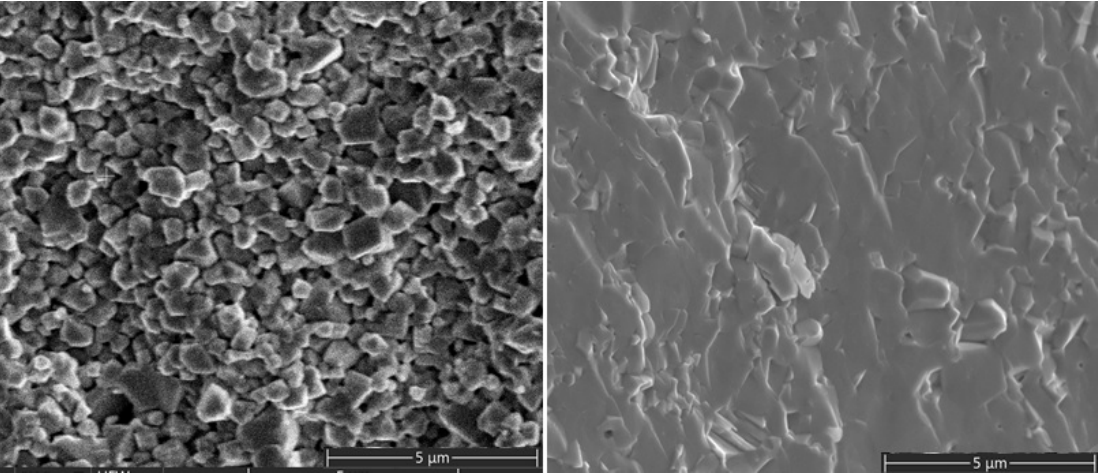
Figure 3. Representative SEM image of fracture surface images of hot ‐ pressed Li 1.25 Cr 0.25 Ti 1.5 O 4 without LBO, left, and with 1% LBO, right.